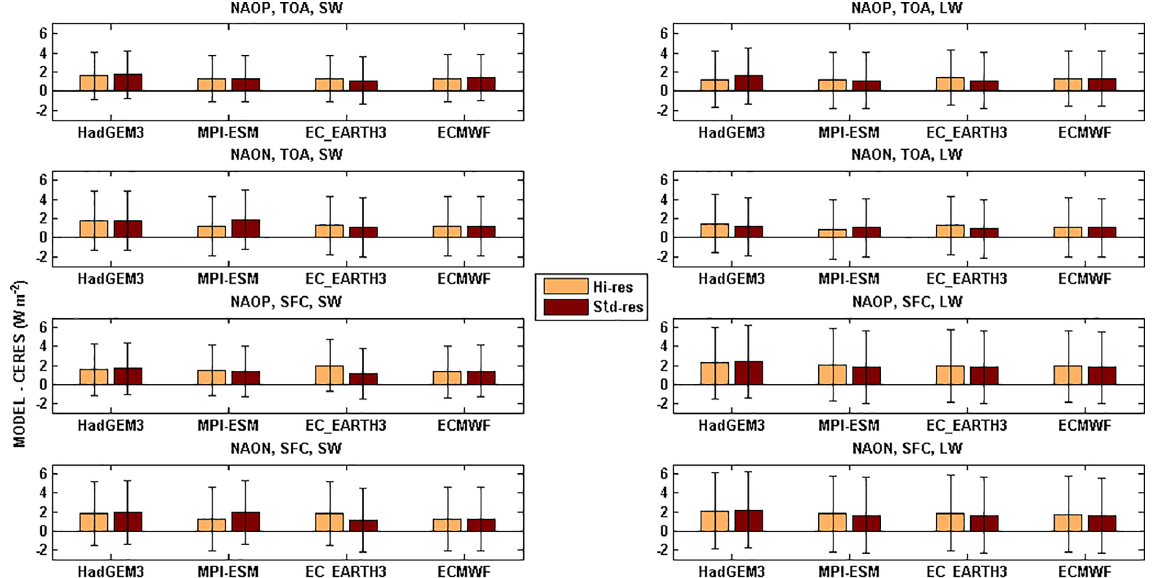
Figure 16. Average absolute errors in the Hi-res and Std-res of the model versions with reference to CERES averaged over Europe (30– 75 ◦ N, 40 ◦ W–40 ◦ E) in the SW (left) and LW (right) during the enhanced positive (NAOP) and negative (NAON) phases of NAO at the TOA (rows 1–2) and at the SFC (rows 3–4). The uncertainty bars show 1 standard deviation in the CERES anomalies for the respective cases as a measure of the variability in the observation